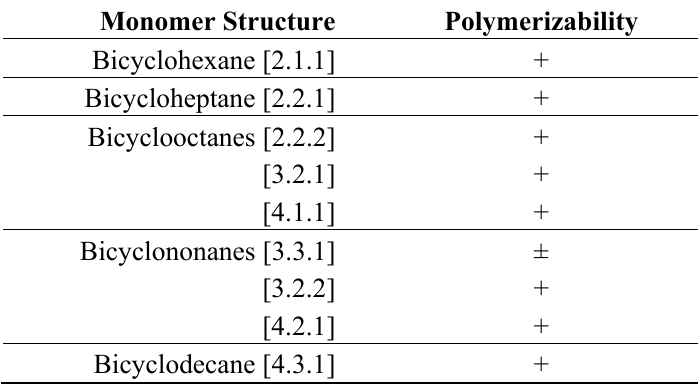
Table 9. Polymerizability of bicyclic monomers in this